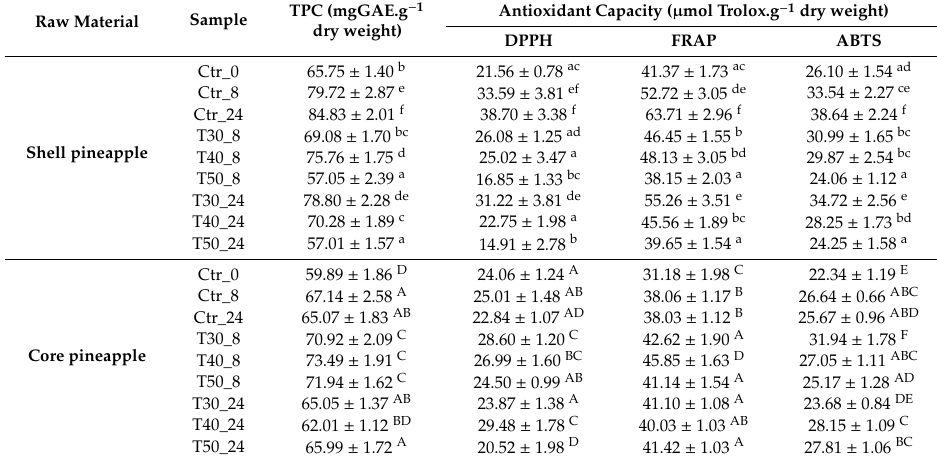
Table 1. Total phenolic content (TPC) and antioxidant capacity of the wounded shell and core pineapple samples submitted to thermal treatments evaluated by three di ff erent methods (DPPH—2,2-diphenyl-1-picrylhydrazyl; FRAP—ferric-reducing antioxidant power; ABTS—2,2 (cid:48)